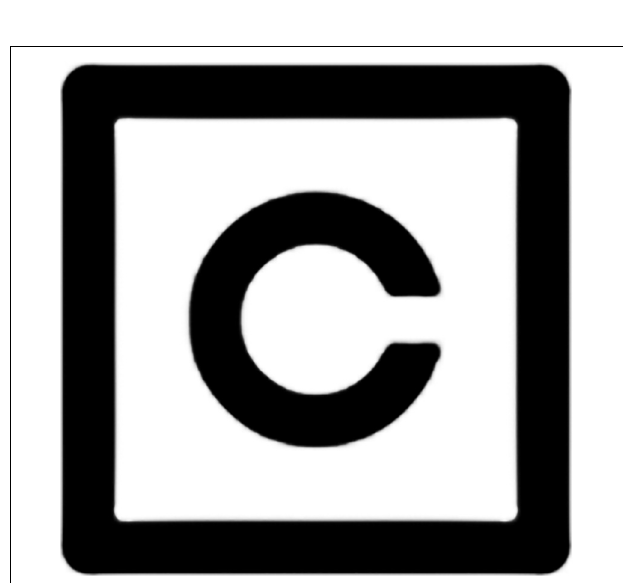
FIGURE 4 | An example of the stimuli (FrACT test with high contrast,